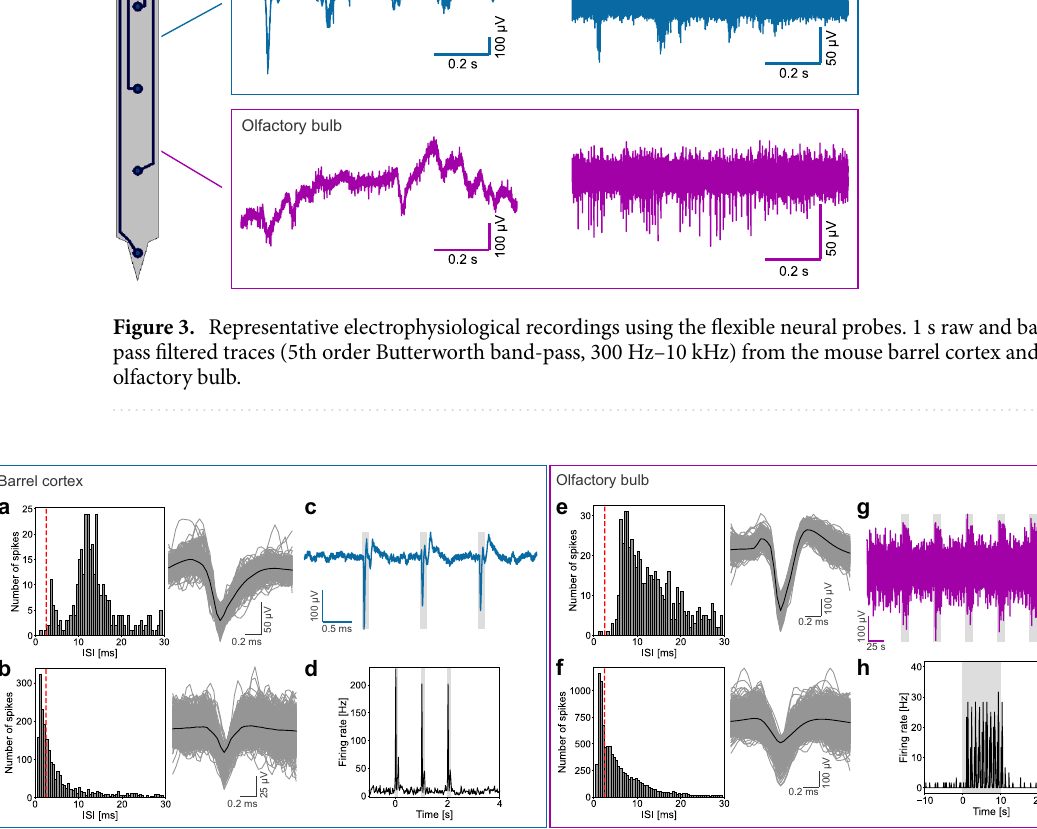
Figure 4. Representative examples for detected signals as well as for high correlation between stimulus presentation and neural activity recorded with the flexible intracortical probes from the barrel cortex and the olfactory bulb. The interspike interval (ISI) distributions and superimposed spike waveforms of isolated spikes for single units ( a , e ) and multi-units ( b , f ). Units where less than 1% of the ISIs were below 2.5 ms (red dashed line) were classified as single units. The mean waveforms are represented by the black lines. The LFPs ( c , g ) and the peri-stimulus time histograms (PSTHs) of unit activity ( d , h ) in response to tactile (barrel cortex) or odorant (olfactory bulb) stimulations. For the recordings from the barrel cortex ( c ), the responses are shown by averaging the raw signal over the 50 stimulation trials where as for the olfactory bulb, the raw signal is depicted for one entire stimulation trial ( g ). The stimulation pulses are represented by grey boxes.